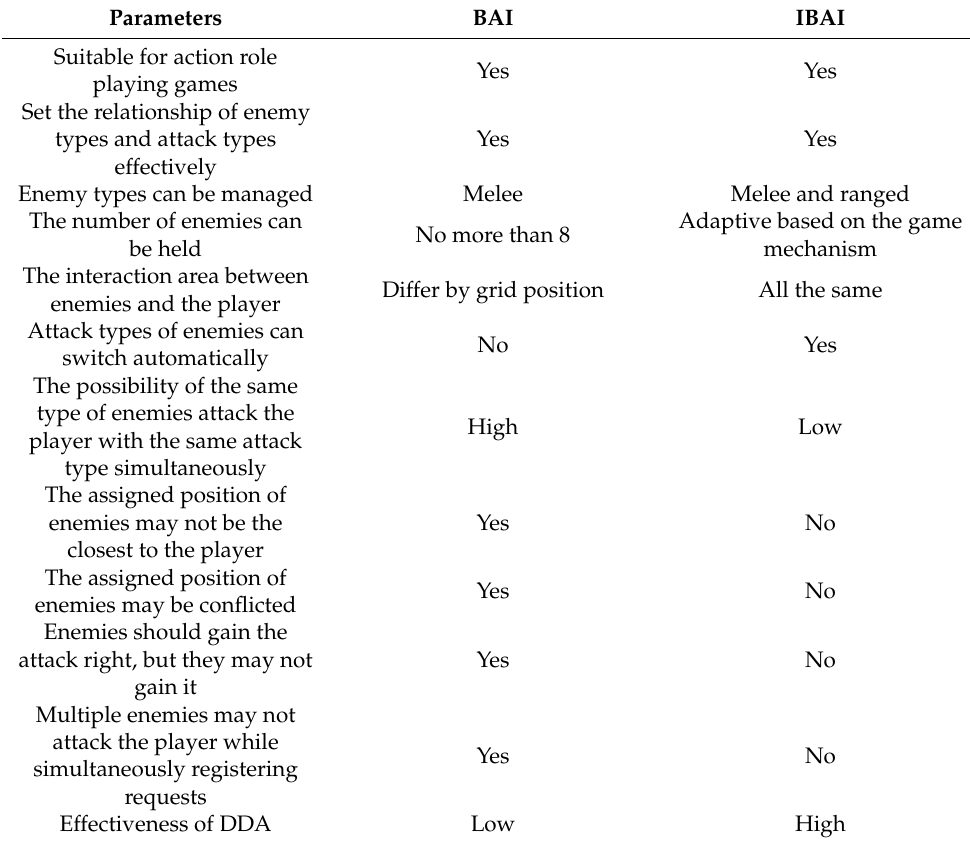
Table 7. Adaptability of BAI and